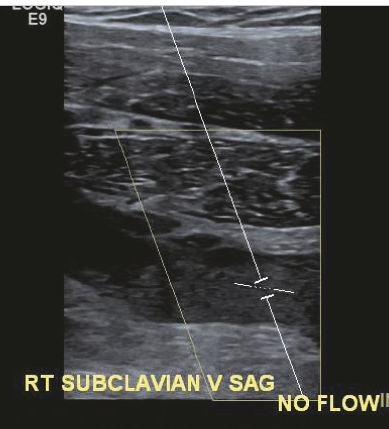
Figure 3: Angiogram showing abrupt cut-off in the contrast flow in the axillary vein (arrow) indicating obstruction.